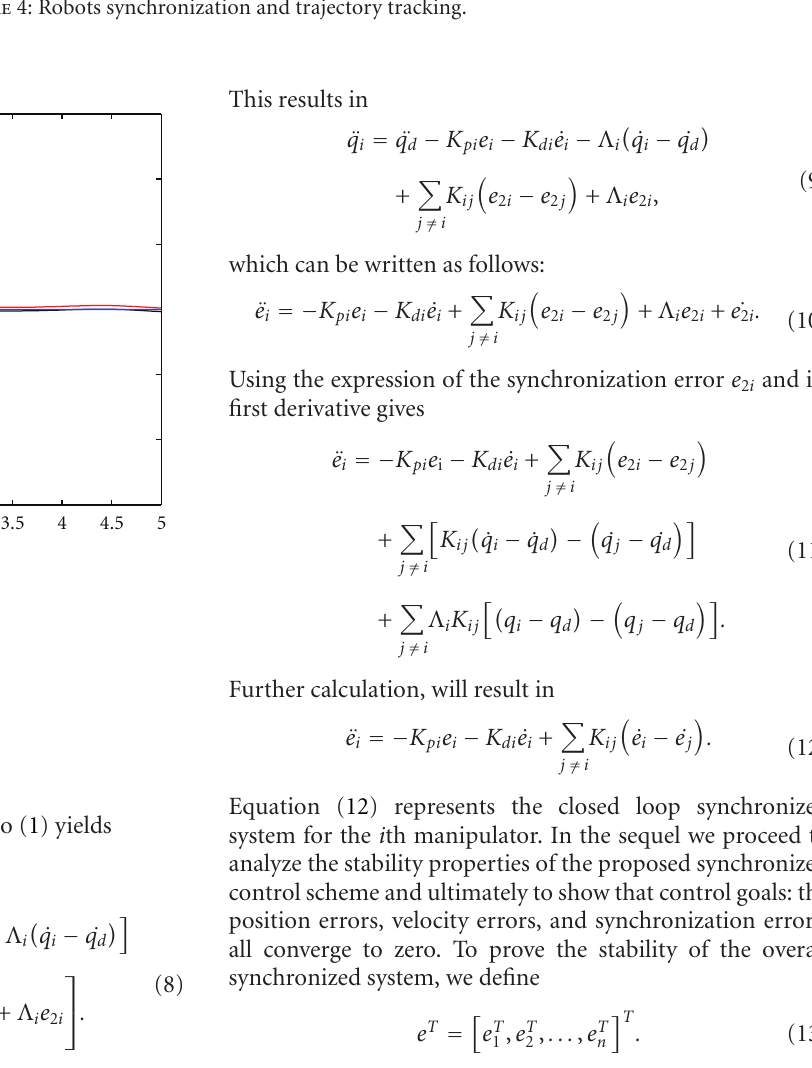
Figure 4: Robots synchronization and trajectory tracking.